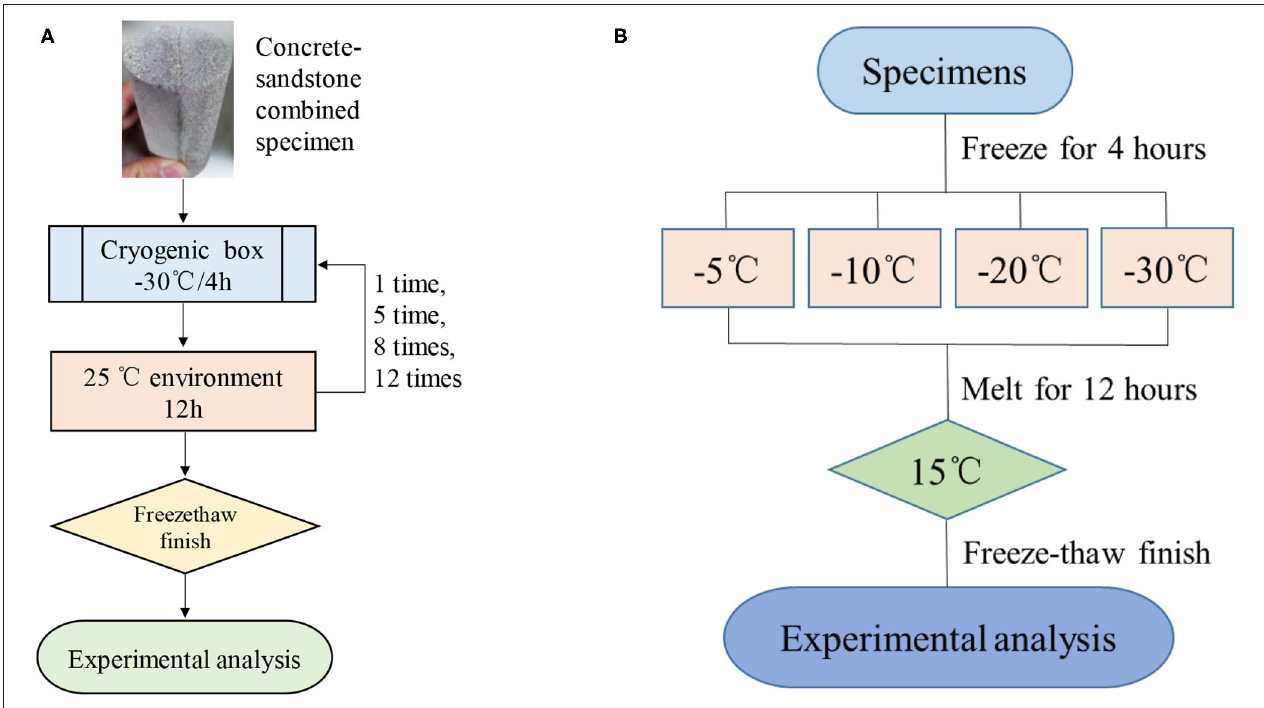
FIGURE 3 | Experimental design of different freeze–thaw methods. (A) Different freeze–thaw cycles; (B) different freezing